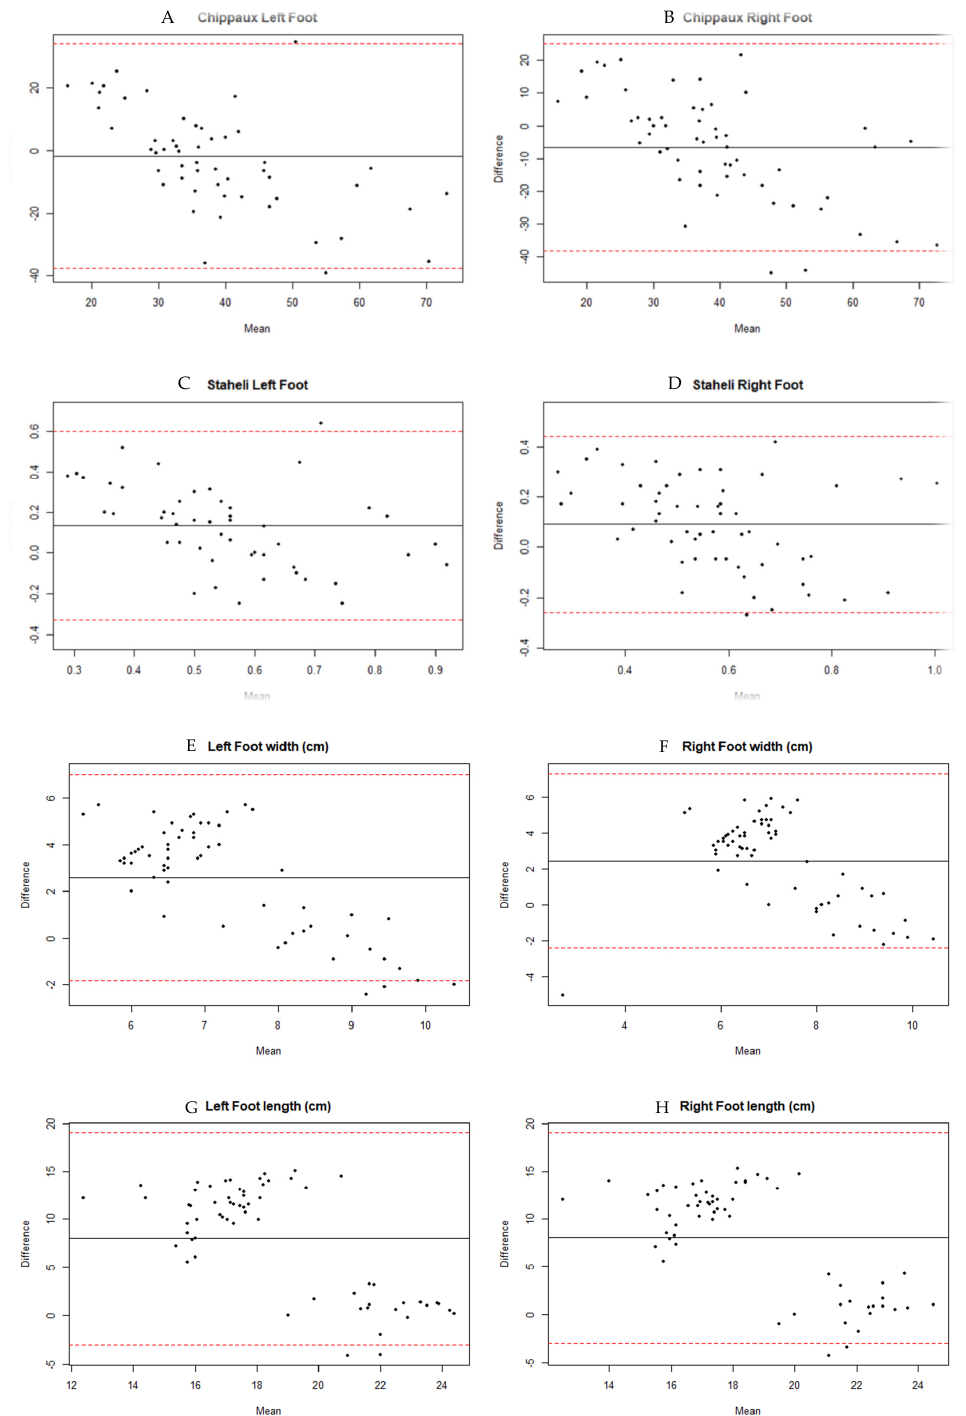
Figure 4. Bland–Altman analysis plots. The central solid line represents the mean difference. The upper and lower solid lines represent the 95% confidence interval for the limits of agreement (mean of difference ± 1.96 * standard deviation of difference). ( A ): Chippaux Index Left Foot, ( B ): Chippaux Index Right Foot, ( C ): Staheli Index Left Foot, ( D ): Staheli Index Right Foot, ( E ): Left foot width, ( F ): Right foot width, ( G ): Left Foot length, ( H ): Right Foot length. The concordance between the pedigraph and platform methods for the diagnosis of flat, cavus or normal foot in the total sample and according to foot, is shown in Table 4. A greater similar concordance was observed in both indices and in the width and length of the foot. Table 4. Concordance between the Chippaux and Staheli index according to foot.